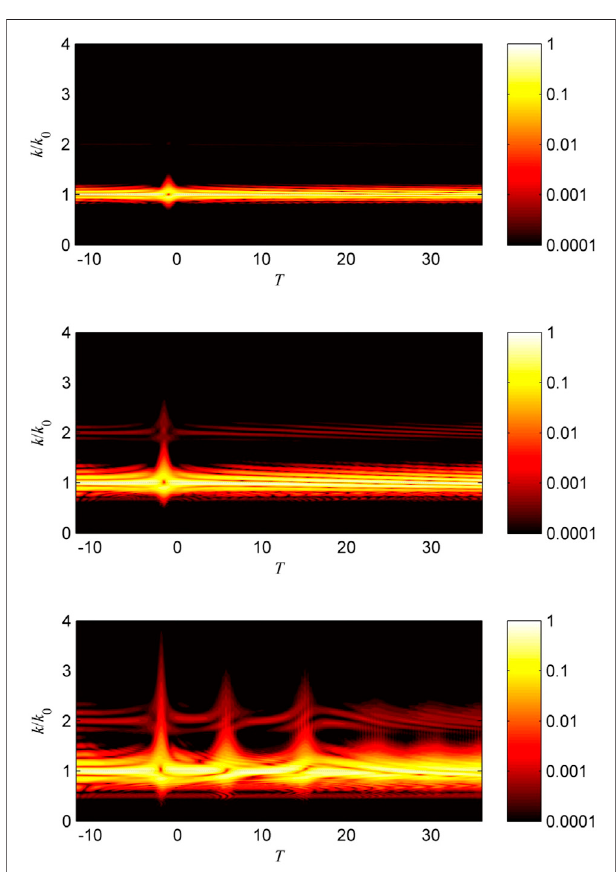
FIGURE 9 | Evolution of the spatial Fourier transform in the cases ka (cid:2) 0.05 (A) , ka (cid:2) 0.10 (B) and ka (cid:2) 0.15 (C) asin Figure6 .Thedecimallogarithm of the normalized Fourier power is in the range from 1 down to 10 − 4